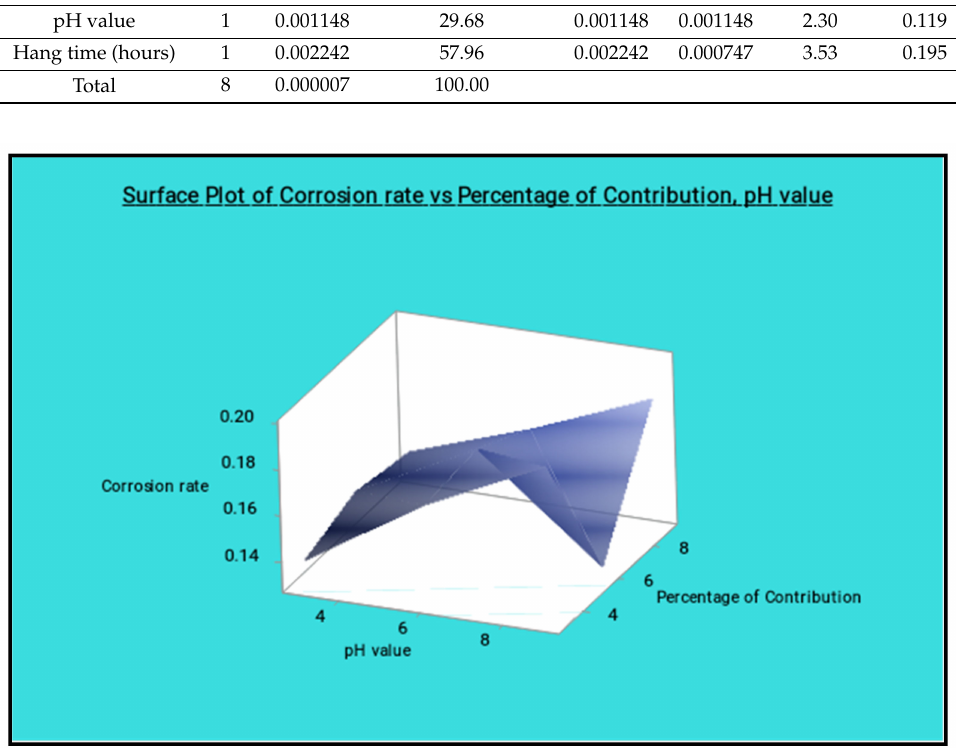
Figure 25. Surface plot of corrosion rate vs. percentage of reinforcement and pH value.